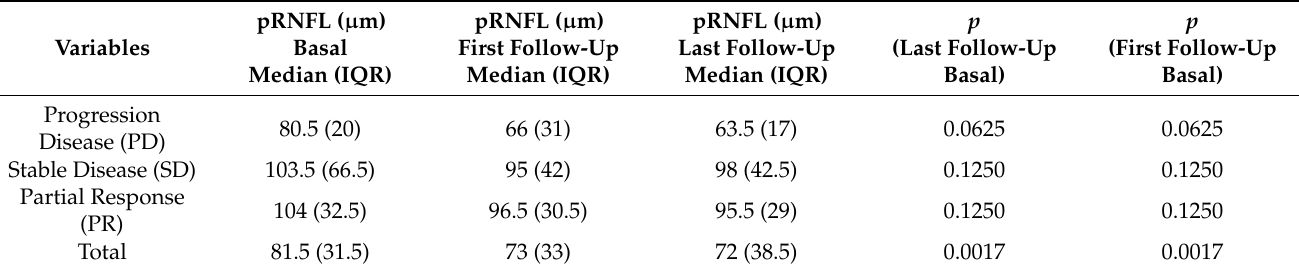
Figure 1. Box plot showing normative Optovue data (Blue plot) in relation to pRNFL at baseline (OCT1 — Orange plot), at the end of treatment (OCT2 — Grey plot), and at last follow-up (OCT3 — Yellow plot). Table 2. Median and IQR values of OCT at different follow-up times by disease status.